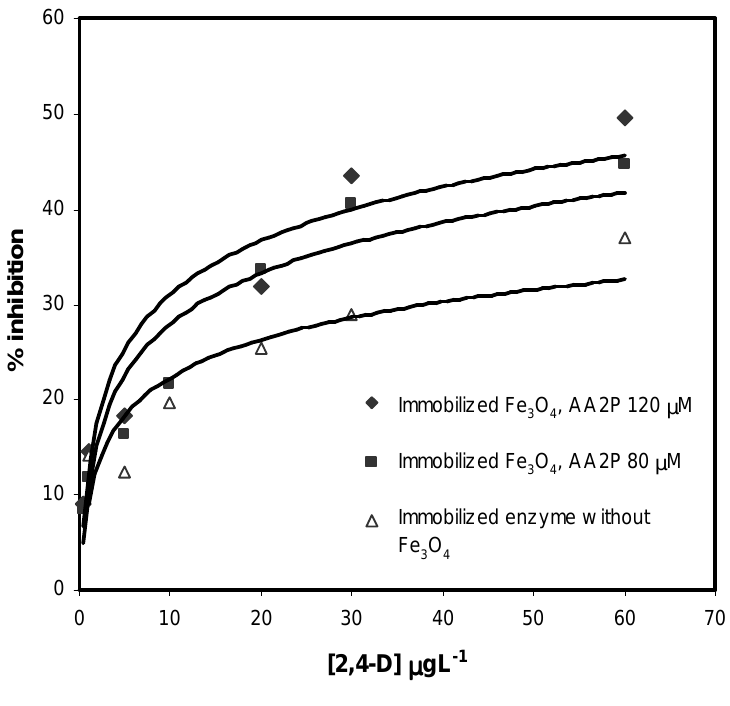
Figure 6. The 2,4-D inhibition profile of the biosensors with and without immobilized Fe O nanoparticles obtained at two different concentrations of AA2P substrate in 0.1 M 3 4 Tris-HCl buffer at pH=8.5, applied potential was 0.6 V versus Ag/AgCl